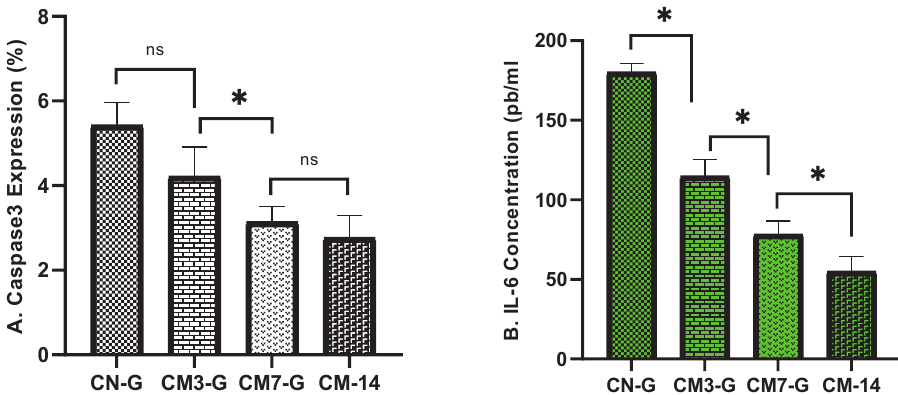
Figure 2. A. Caspase 3 Expression in Liver, and B. IL-6 Concentration. Post Hoc Analysis: * p<0.05; ns: not significant